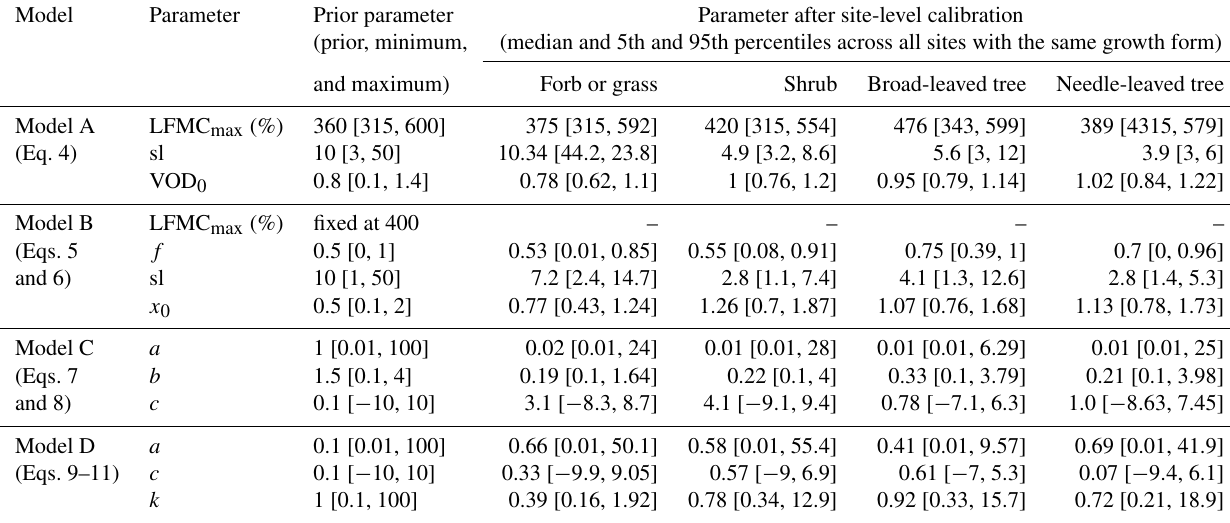
Table 2. Overview about prior parameter values and results after site-level calibration for the four models. Model Parameter Prior parameter Parameter after site-level calibration (prior, minimum, (median and 5th and 95th percentiles across all sites with the same growth form) and maximum) Forb or grass Shrub Broad-leaved tree Needle-leaved